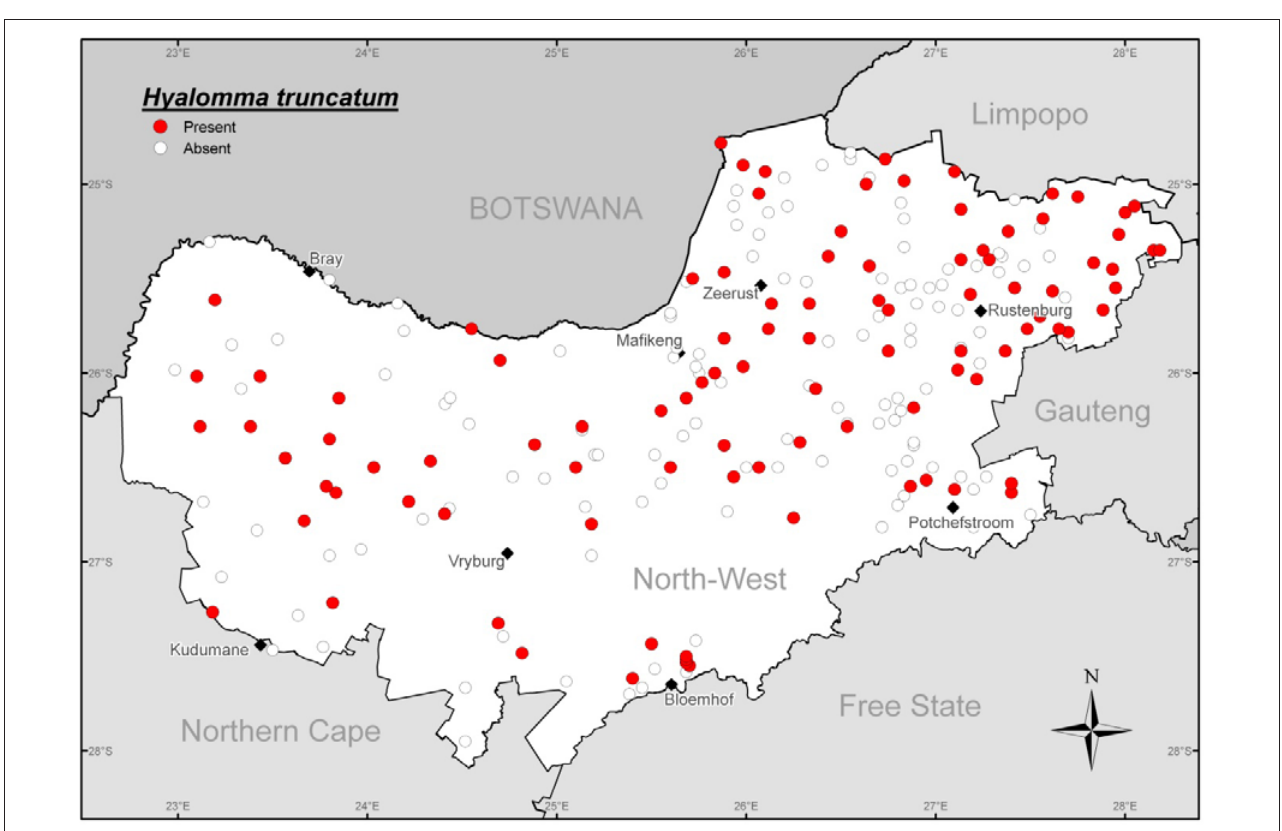
FIGURE 5: The geographic distribution of Hyalomma truncatum in the North West province, South